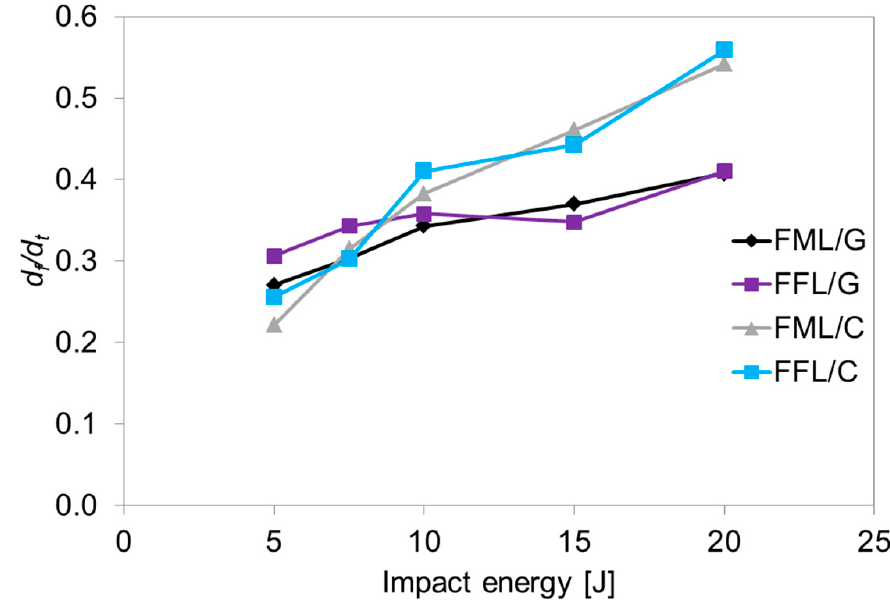
Figure 5. The relation between d f /d t coefficient and impact energy. In most cases, a higher value of the d f / d t ratio was noted for FFL/C, on average by 3.5% in comparison to FML/C. The lowest d f /d t coefficient for FFL/C was 0.26, while for FML/C it was 0.22 at the impact energy 5 J, while at the energy 20 J, this value increased to 0.56 and 0.54, respectively. The contribution of permanent deformation in the total deformation increases from 20% to over 50% in the energy range from 5 to 20 J, both for FML/C and FFL/C laminates. This is due to the failure progression with increasing impact energy. At low energies, the energy is accumulated by a deformation in the elastic range. When the impact energy reaches the maximum elastic energy absorption the energy absorption process by permanent deformation starts (plastic deformation of metal layers and failure of composite and foam layers). Similar observations were noted in the case of glass laminates, where aluminium–glass foam laminates were characterized by higher d f /d t values. The difference between final deflection and total deflection of FFL/G averages 14% and 8.5% compared to FML/G laminates. The d f /d t coefficient in FFL/G laminates has a higher value at all energies except 15 J and is higher by an average of 5%. The lowest value was 0.27 for FML/G and 0.31 for FFL/G, while the highest value equaled 0.41 and it was the same in both cases. Simultaneously, the FFL/G with an impact energy from 10 J to 15 J has a different trend in Figure 5. This phenomenon can be related to the changing of the damage mechanisms which will be deeper analyzed in section of damage analysis. The difference between the values of the d f / d t coefficient of carbon- and glass-based specimens is due to the deformability of the fibres; carbon fibres have an elongation from 1.5 to 2% and glass fibre around 5.5% [44]. The noted differences in d f / d t coefficient between conventional fibre metal laminates and fibre foam metal laminates may indicate the influence of the foam layer on the deformation process, energy accumulation ability and plate elasticity (see Figure 5). Therefore, the bending stiffness ( K ) of laminates was complementarily analyzed in relation to areal density (Figure 6). The bending stiffness parameter describes the impact resistance and delamination vulnerability